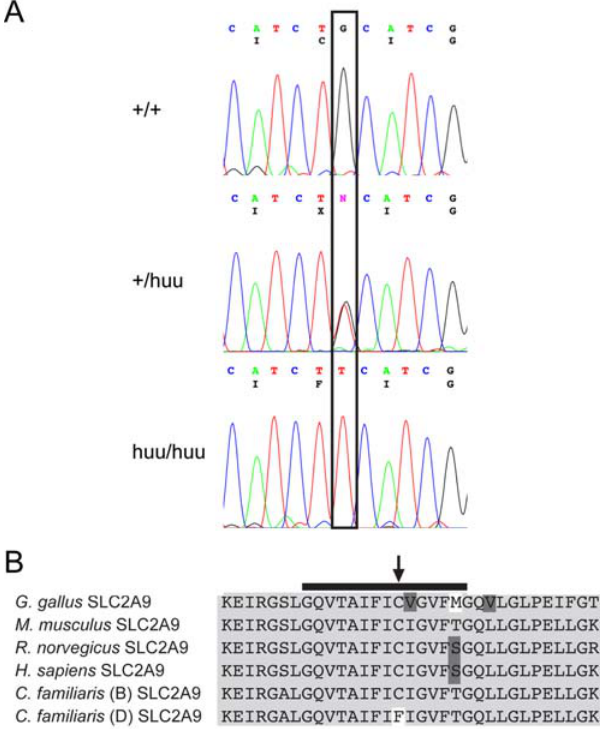
Figure 5. Sequence and expression of canine SLC2A9. (A) The electropherograms for the SLC2A9 sequence from a non-Dalmatian dog ( + / + ), heterozygous backcross dog ( + /huu), and a Dalmatian dog (huu/ huu) are shown. The nucleotide sequence is given, with the amino acid sequence presented below. The box shows the location of the mutation. (B) Protein sequence alignment of SLC2A9 around the